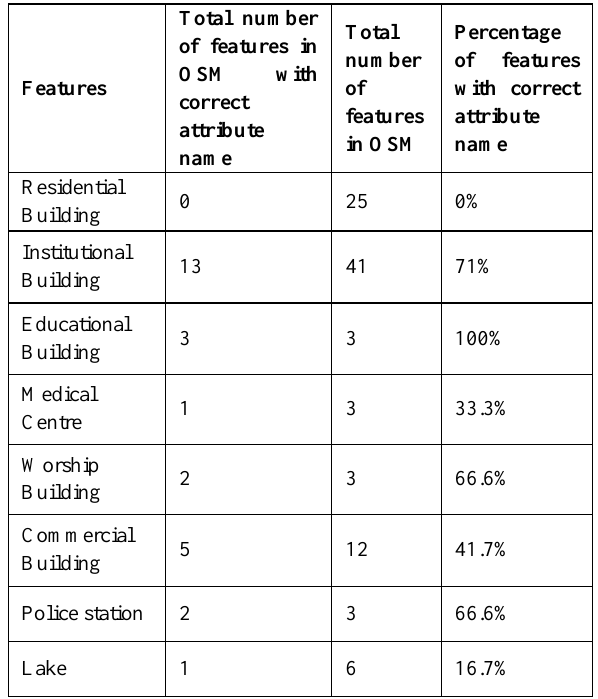
Table 11: Number of building features with correct attribute